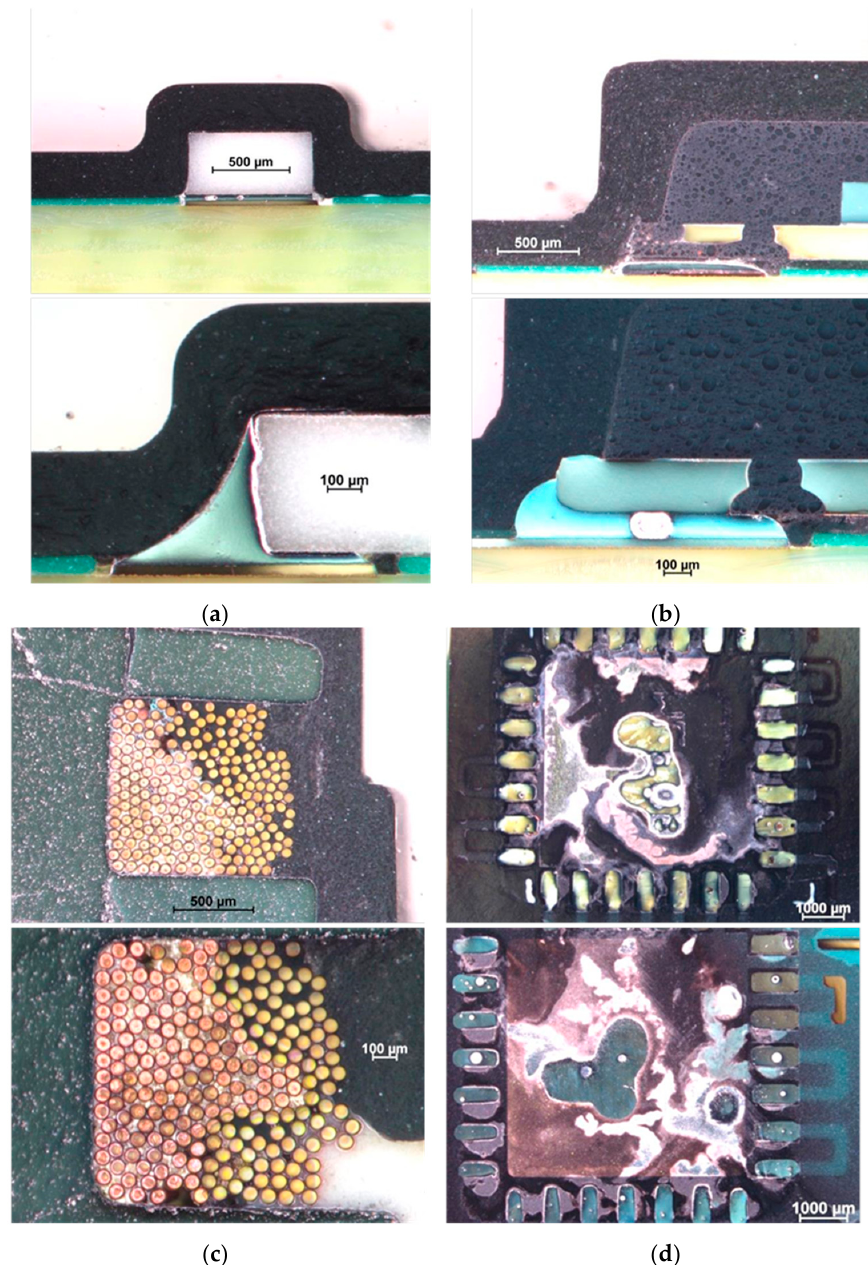
Figure 18. Results from microscopic analysis II. ( a ) Resistors and ( b ) MLF had a well-filled encapsulation when no irregularities in the device geometry or mounting were present. ( c ) The loose wires of the induction coil also had a well-packed encapsulation. ( d ) The thin gap under the MLF was also filled, though only